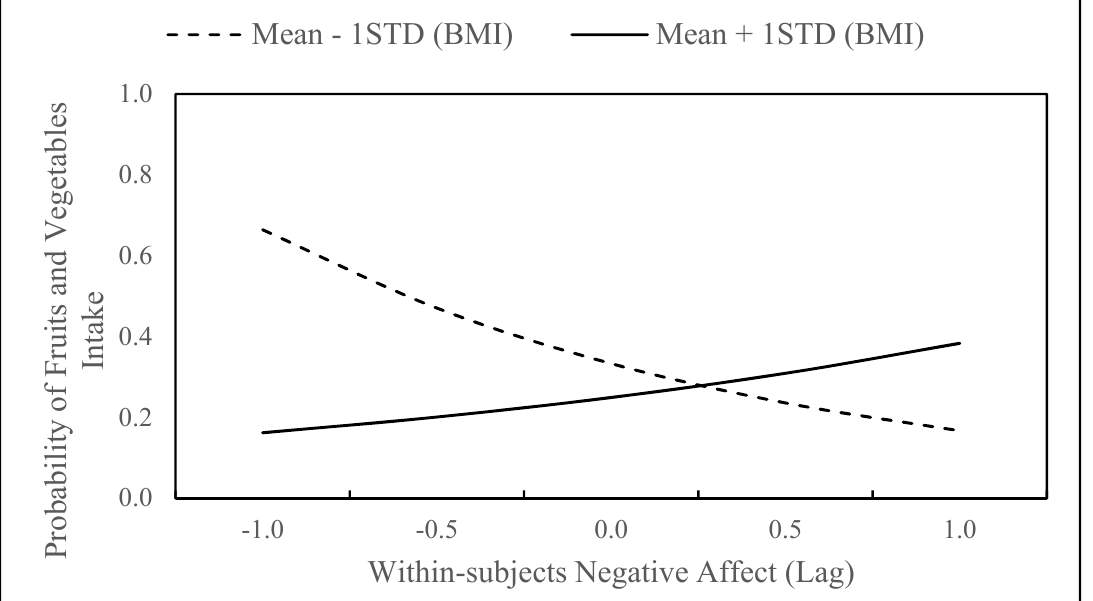
Figure 3. Two-way interactions of lagged within-subjects negative affect and pre-pregnancy BMI predicting intake of fruits and vegetables. The x-axis shows values of within-subjects negative affect with 0 representing one’s own average level of negative affect, positive values representing greater than one’s own average level of negative affect, and negative values representing lower than one’s own average level of negative affect. The y-axis represents the probability of fruit and vegetable intake.